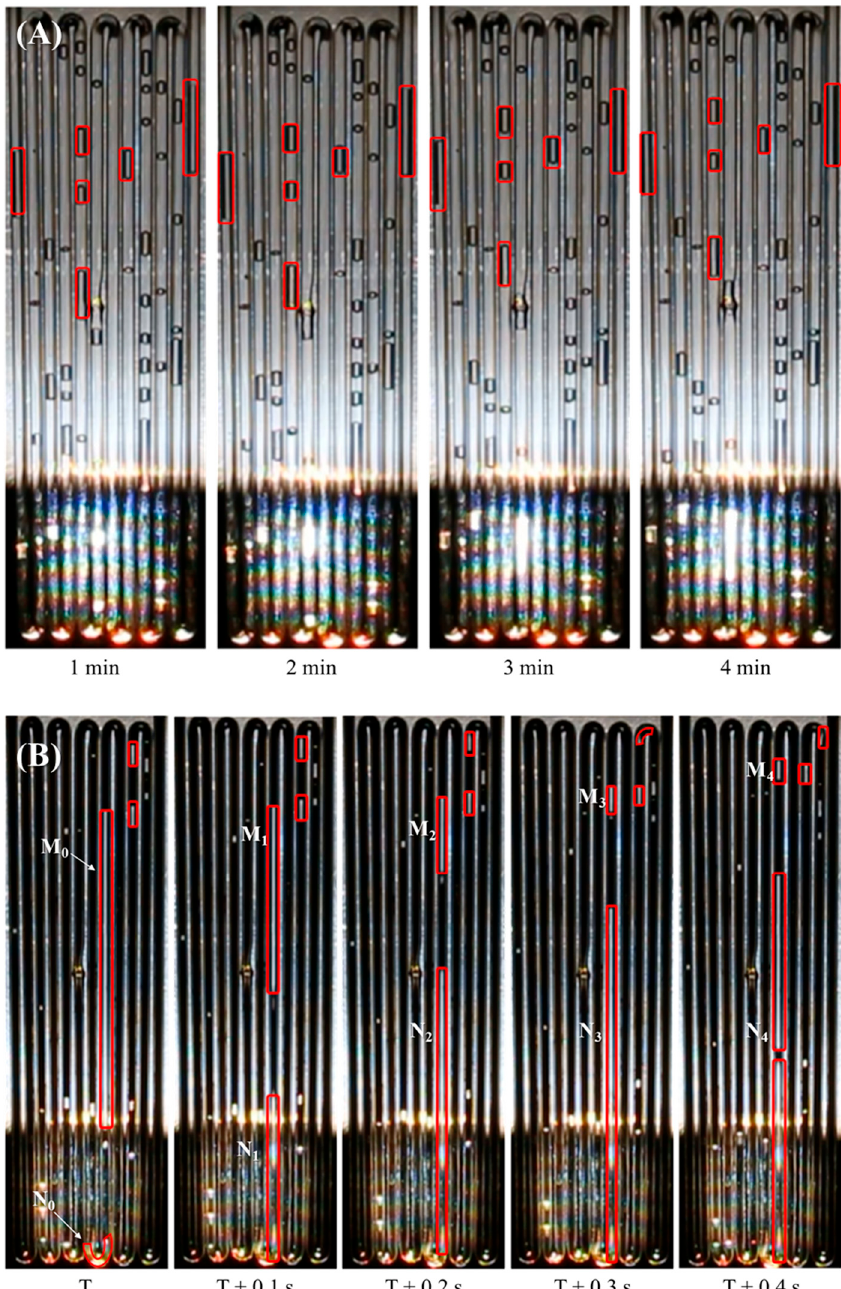
Figure 10. Bubble growth and dynamic movement of the PHP filled with ( A ) DI water and ( B ) 0.5 wt% MWCNTs with a filling ratio of 80% (the time 0 s represents that the solar simulator is turned on). The red rectangles indicate the location and size of the selected gas plugs at different times.